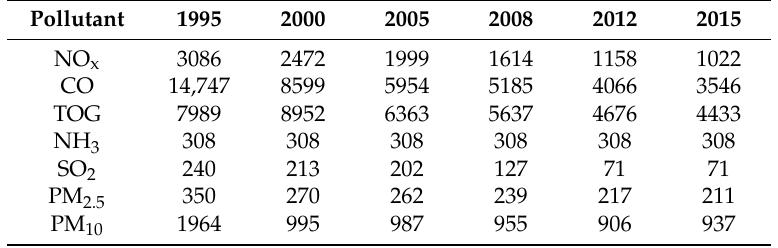
Table 2. Domain-wide average emissions (tons per day) from scaling 2012 emissions (2016